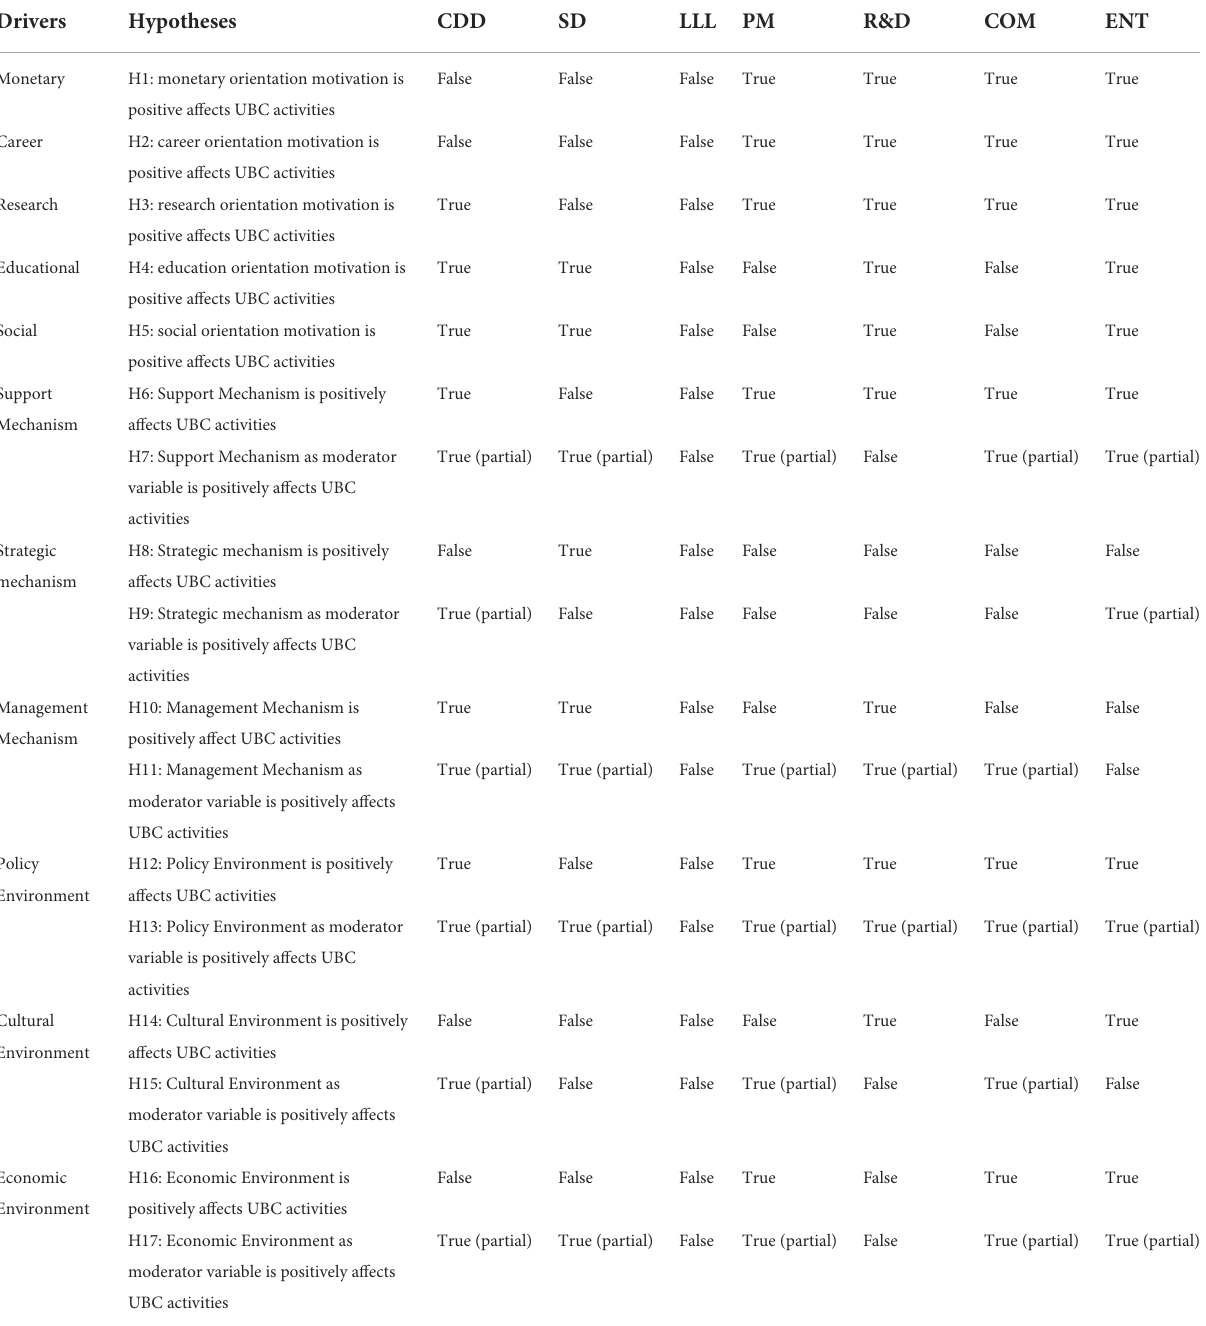
TABLE 3 Summary of the